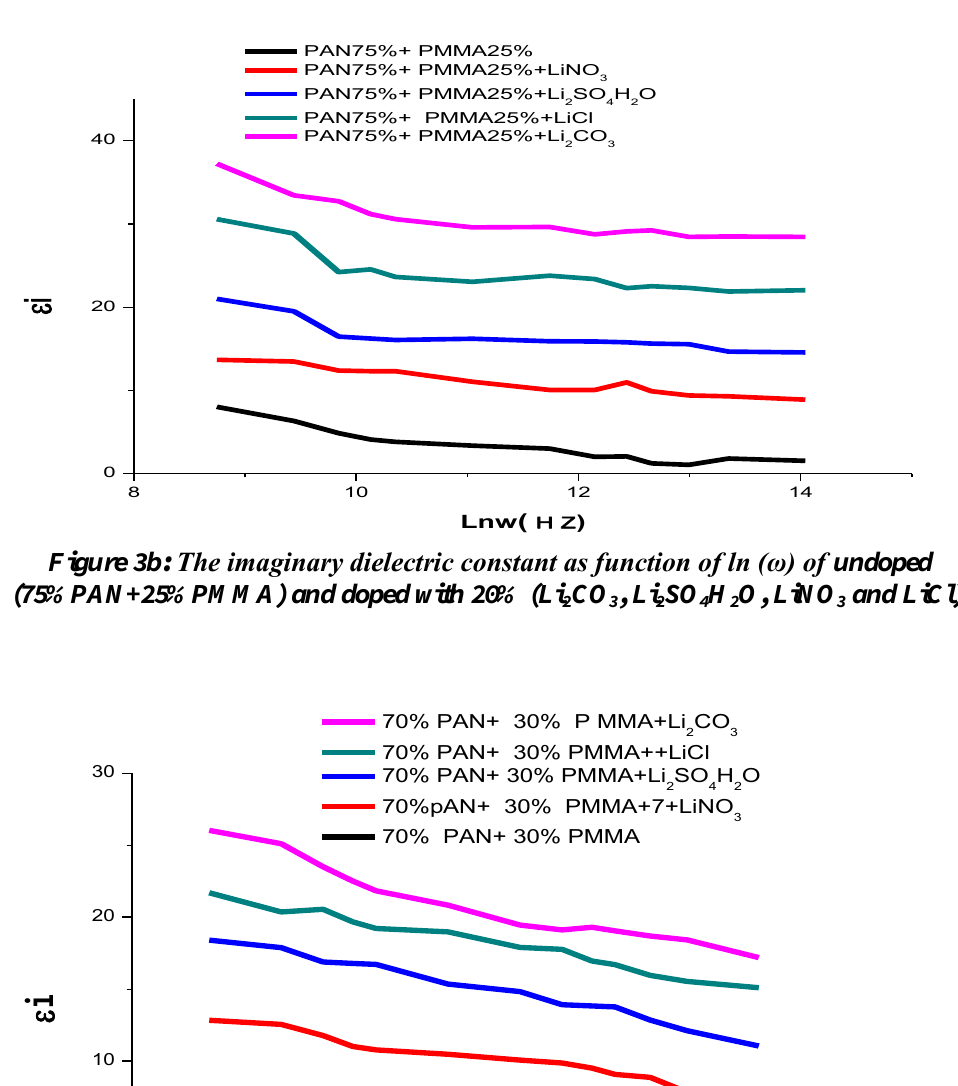
CO , Li SO H O, LiNO and 2 3 2 4 2 3